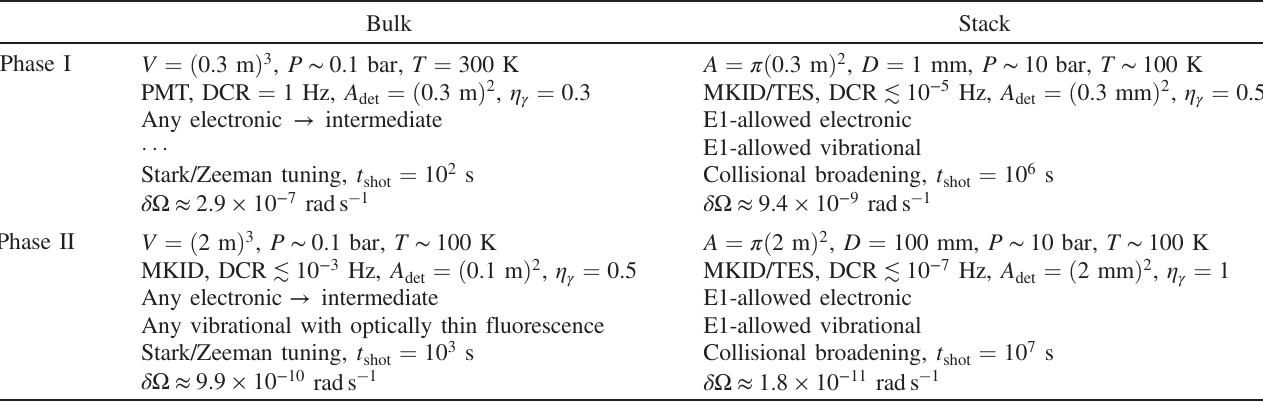
TABLE II. Experimental configurations and their specifications for phase I prototypes, and ultimate phase II implementations. The six lines in each cell correspond to (1) thermodynamic variables, (2) photodetection parameters, (3) accessible electronic transition types, (4) accessible vibrational transition types, (5) frequency coverage strategy, and (6) Rabi frequency sensitivity at SNR ¼ 1 over frequencies where blackbody radiation can be ignored, assuming that collisional broadening dominates the absorption width. The frequency coverage strategy of the bulk configuration can be used by the stack setup, and vice versa, albeit typically at lower sensitivity in a DM search over a broad energy range. The four versions are abbreviated as BI, BII, SI, and SII. Photodetection acronyms include dark count rate (DCR), photomultiplier tube (PMT), microwave kinetic inductance detector (MKID), and transition edge sensor